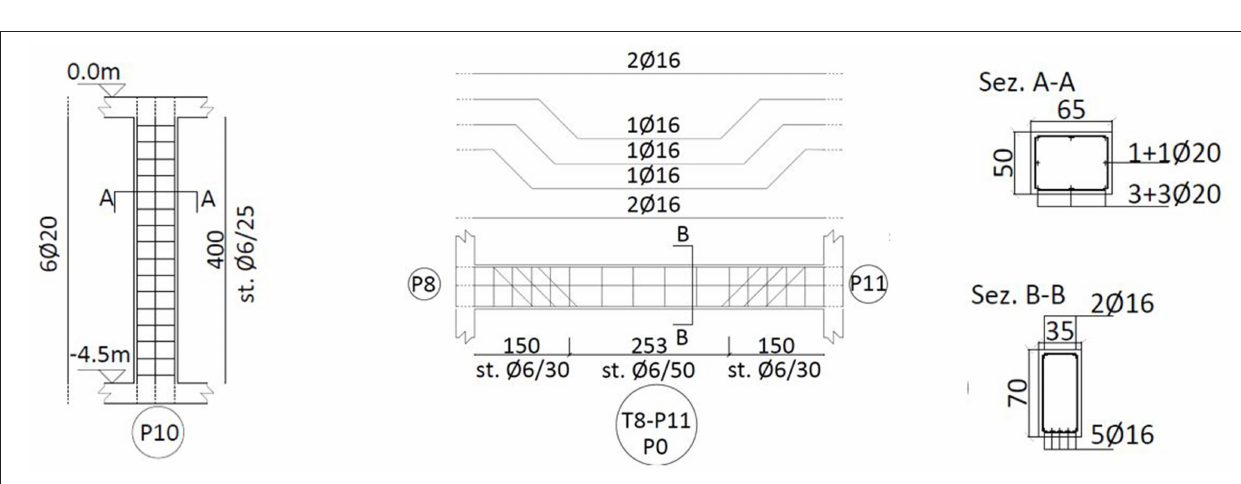
FIGURE 3 | Typical reinforcement details of columns and